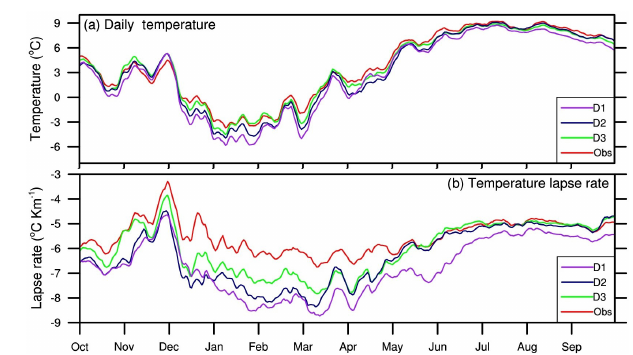
Figure 6. Daily station averaged (a) temperature and (b) its lapse rate at three WRF resolutions and observations (plotted as 10-day moving